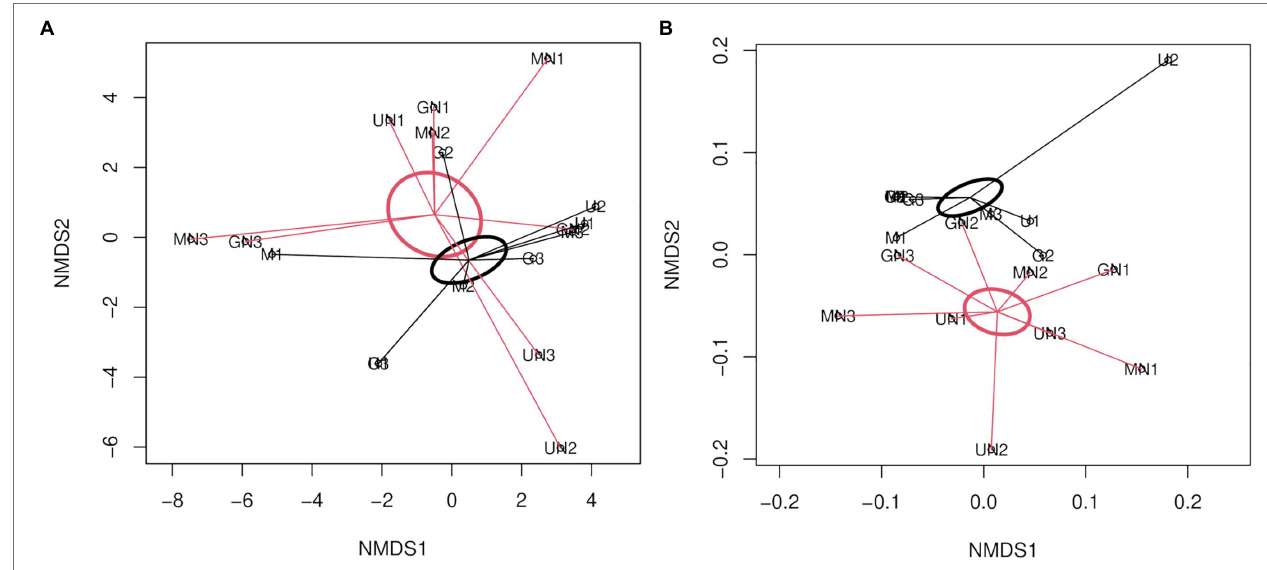
FIGURE 4 | Non-metric multidimensional scaling of AOB using (A) Aitchison distance (Stress = 0.13, R 2 = 0.98; B ) generalized UniFrac distance (Stress = 0.08, R 2 = 0.99). The SE of fertilized and unfertilized groups is indicated with red and black ellipses, respectively. The letter M in the labels of samples indicates mowing termination, letter G desiccation with glyphosate and letter U untreated control. Letter N indicates N fertilization and the number identifies the replicate of each